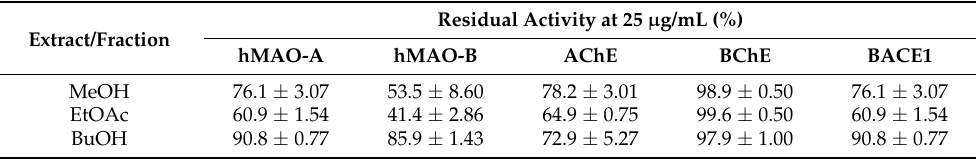
Table 1. Inhibitions of hMAO-A, hMAO-B, AChE, BChE, and BACE1 by the MeOH extract of C. lineata pods and its EtOAc and BuOH fractions a .